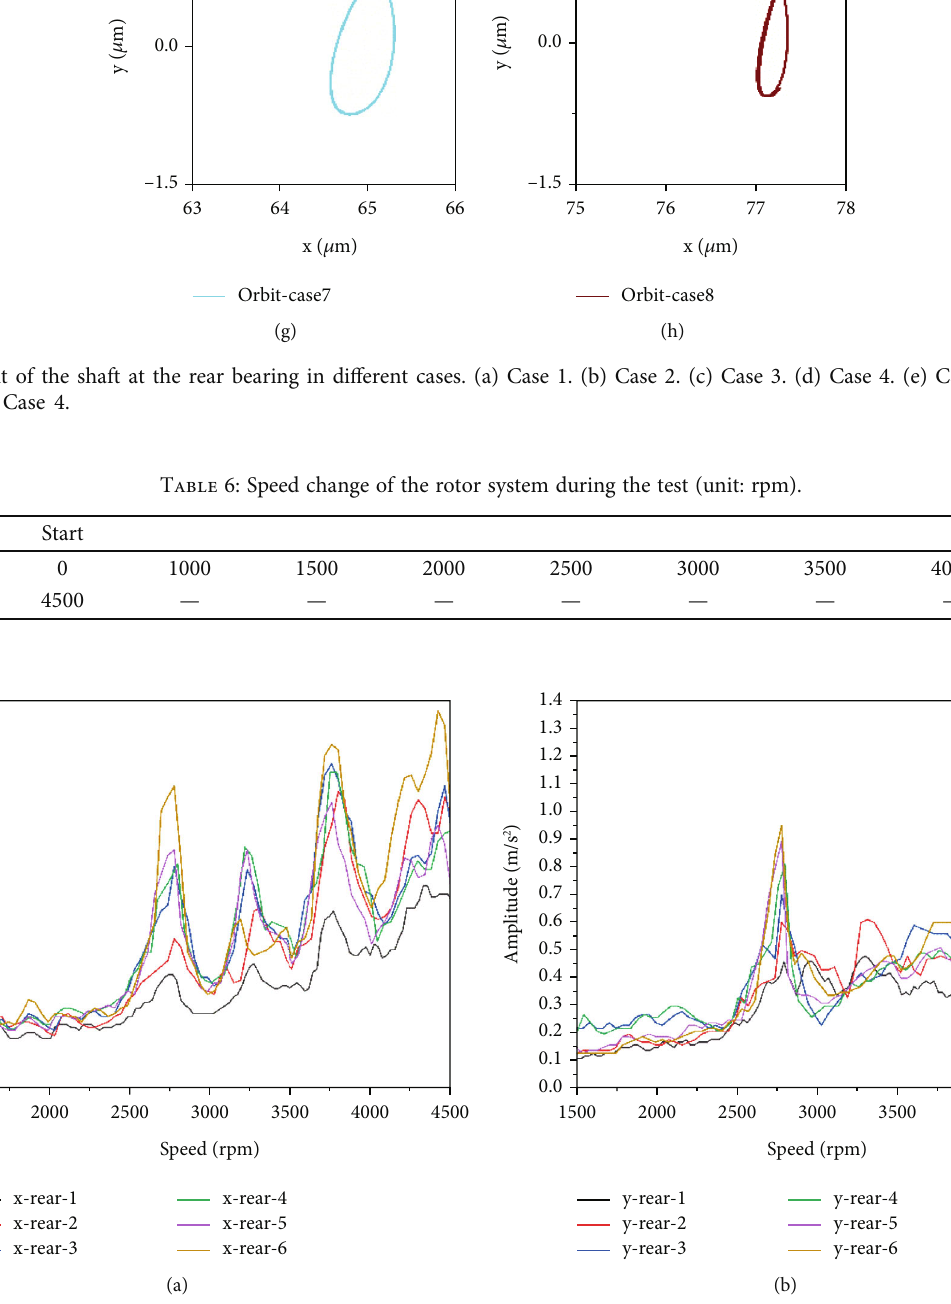
Figure 25: Acceleration response of the rear bearing during run-up process. (a) Response in the x -axis direction. (b) Response in the y -axis direction.